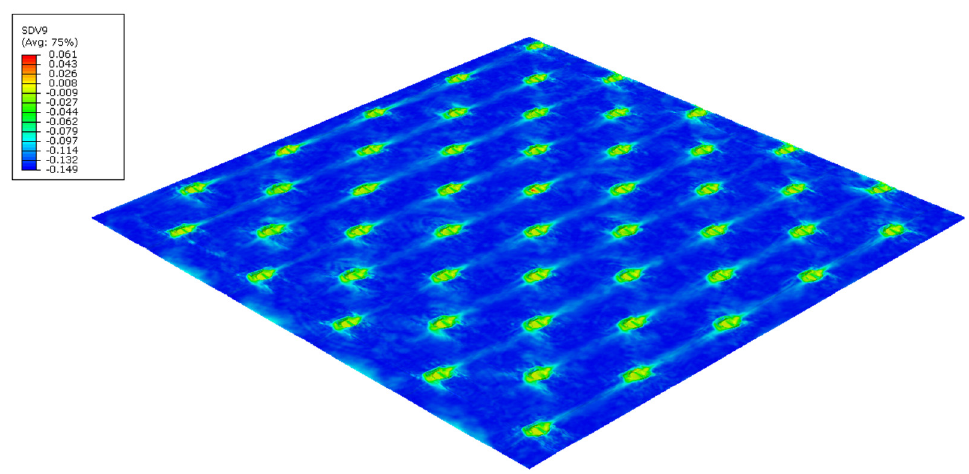
Figure 20. Plastic-stress-field finite-element results for micropattern with round finishing.